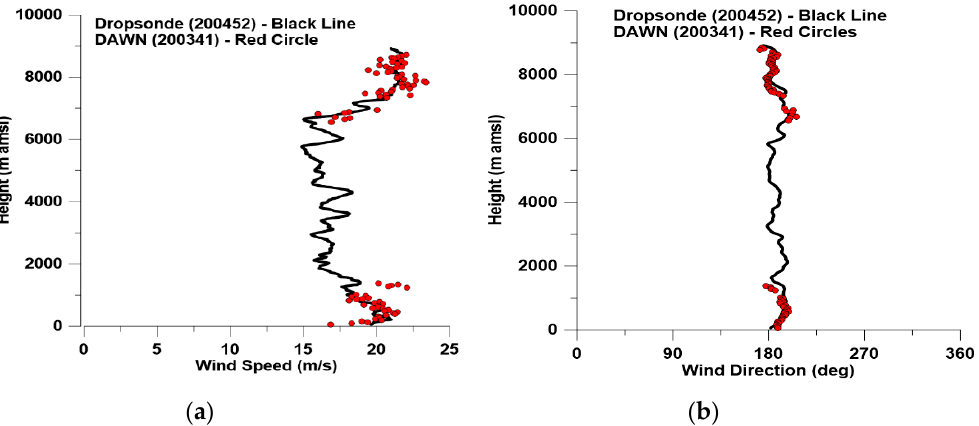
Figure 9. DAWN-dropsonde comparison of wind speed ( a ) and wind direction ( b ) for a convectively active case on 21 June 2017 ~200400Z.